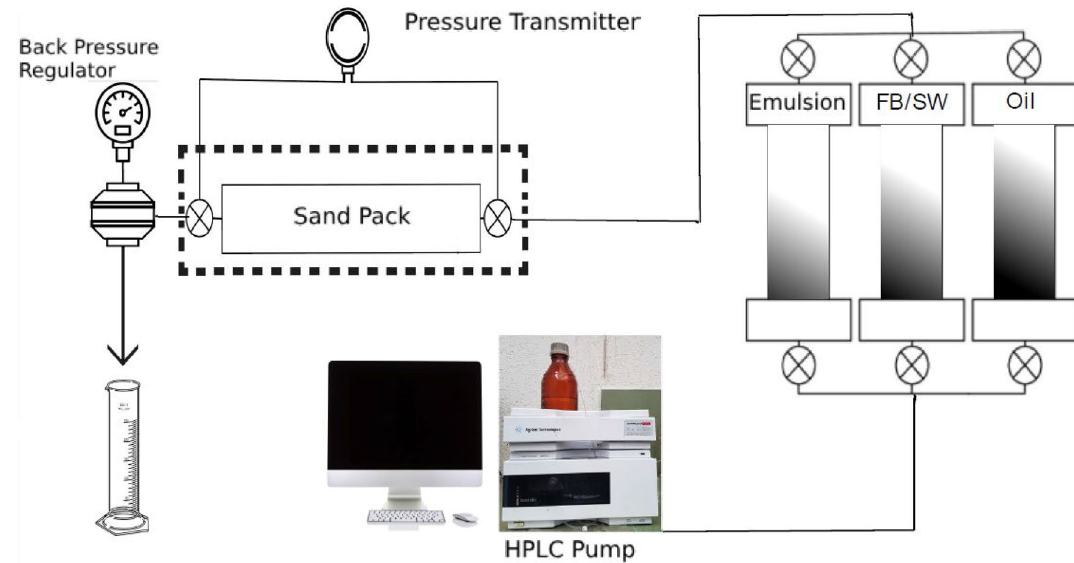
Fig. 3 Schematic of the flooding setup Table 2 Summary of sandpack flooding experiments and their